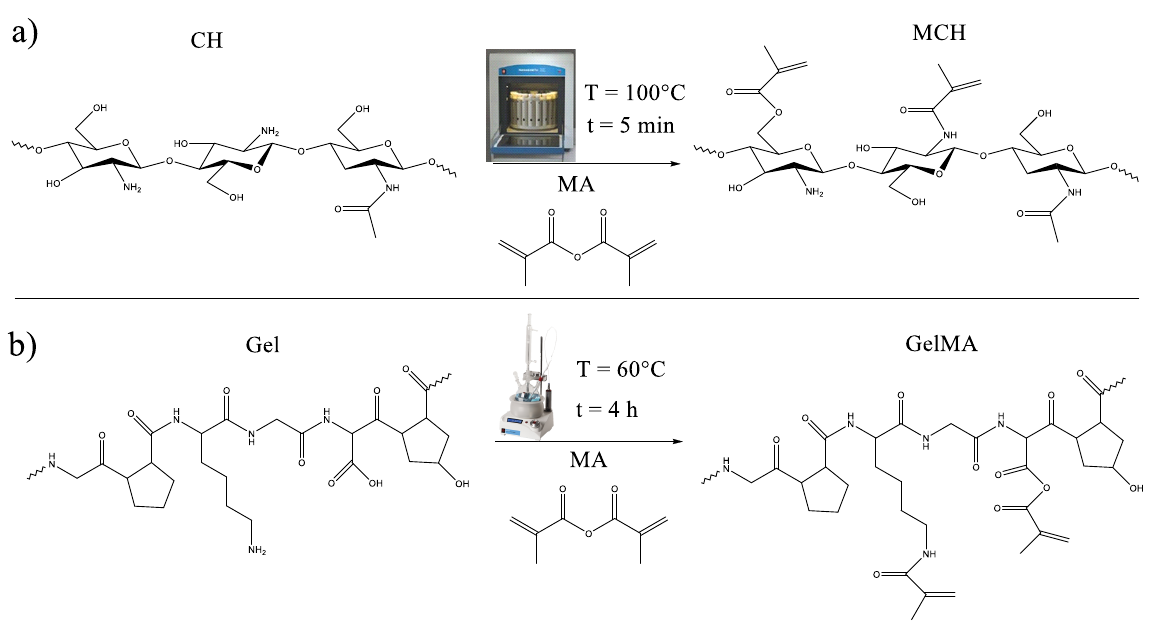
Figure 1. Scheme of the methacrylation reaction of ( a ) chitosan and ( b ) gelatin.